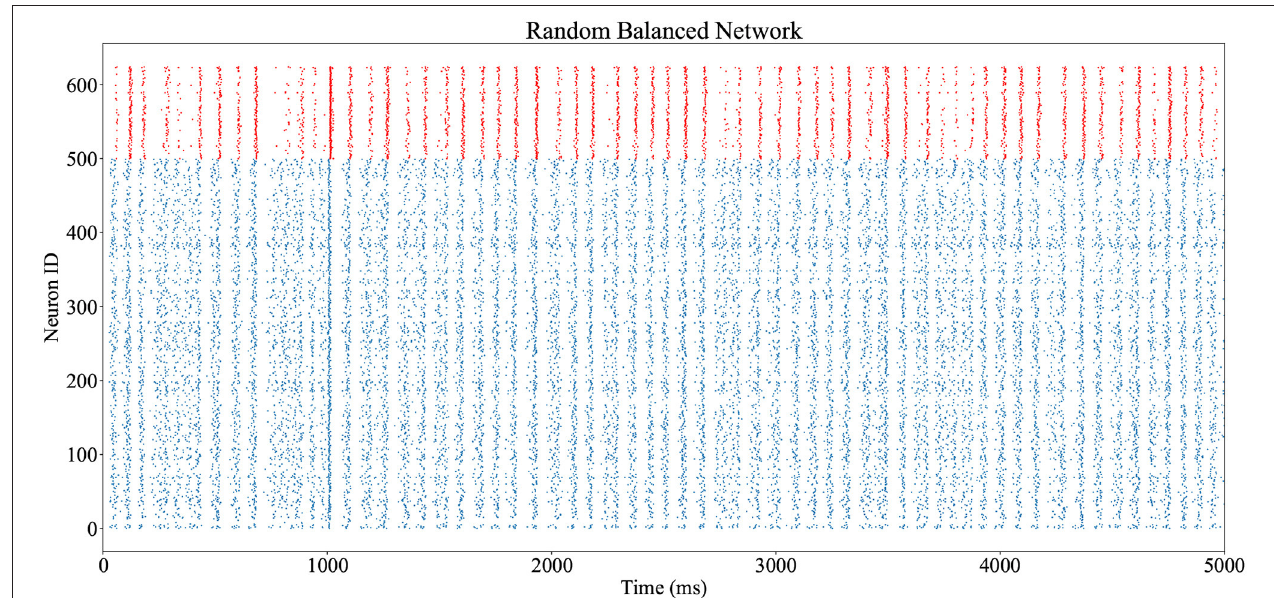
FIGURE 10 | Output spike trains from realtime execution of the random balanced network of Figure 3A , from the PyNN script of Code S1. Spikes from inhibitory neurons are shown in red, and excitatory neurons in blue. The excitatory population receives an additional stimulus at t = 1s.